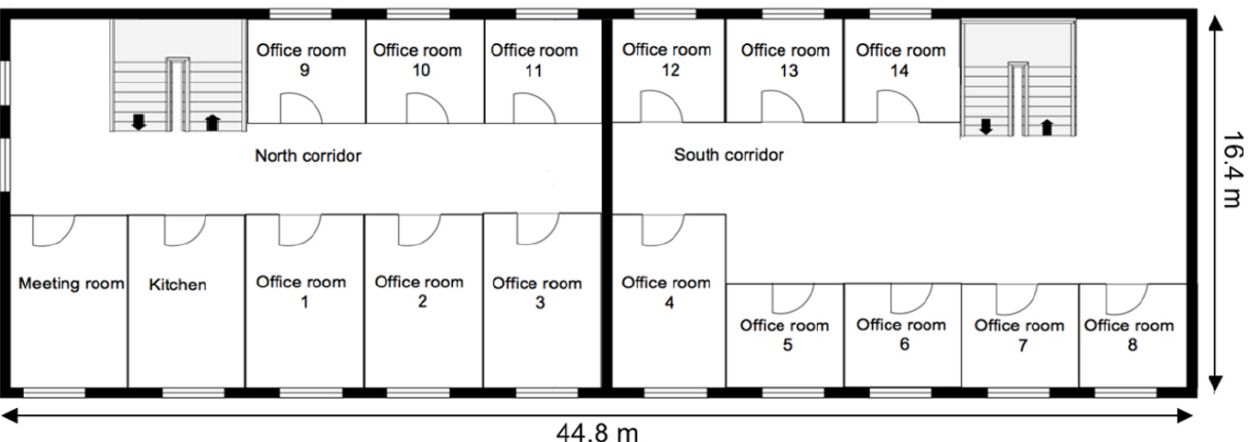
Figure 4. The layout of the modelled and studied floor.